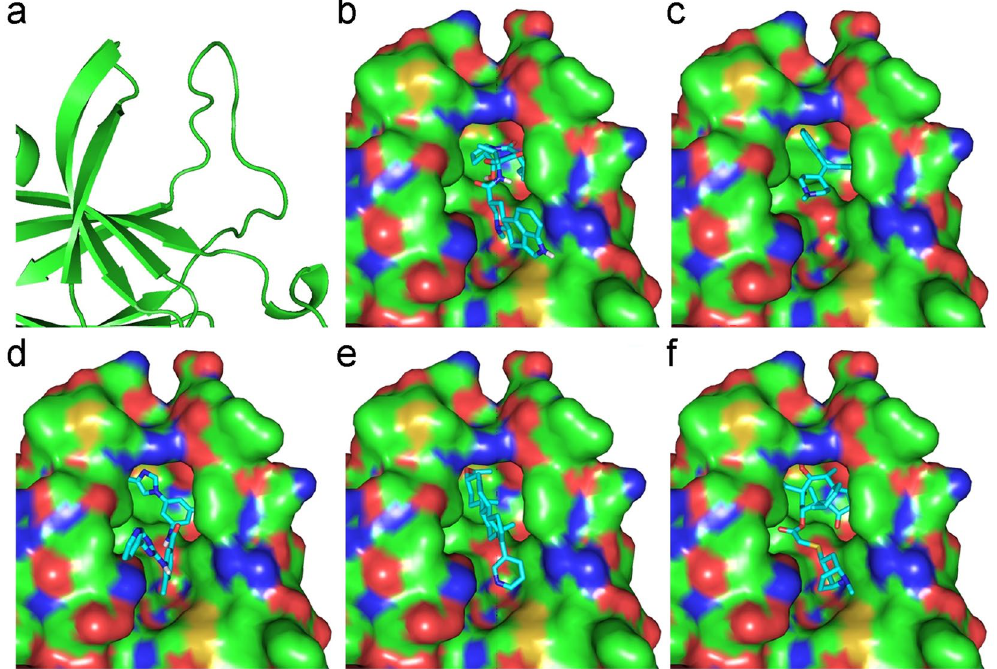
Figure 3. Molecular docking poses of five drugs in the cavity. Ligand-binding domain of EphA4 ( a ), and the docking conformations of ergoloid ( b ), cyproheptadine ( c ), nilotinib ( d ), abiraterone ( e ), and retapamulin ( f ) in the binding sites. The conformations with the lowest docking energy were selected for demonstration. The proteins are shown in surface representation ( b – f ), whereas drugs are shown as